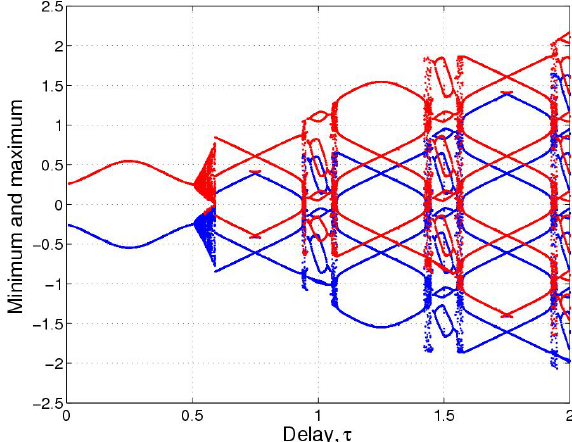
Fig. 11. Local maxima (red) and minima (blue) of model solutions as a function of delay τ ; the other parameter values are fixed at κ = 11 and b = 2. Notice the aperiodic regimes between periodic windows of gradually increasing